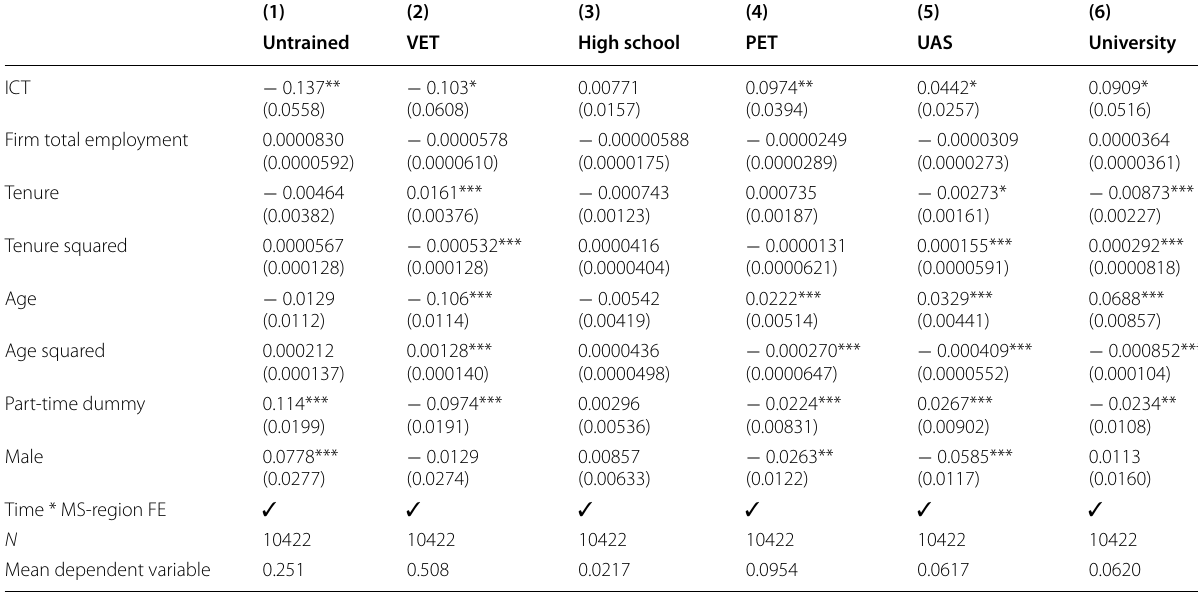
The table shows OLS coefficients of fixed effects estimates of a firm pseudo-panel with cells defined based on MS-region, industry, and firm size. Standard errors in parentheses are clustered at the cell level. N reports the number of pseudo-panel cells that contain at least one firm. The main explanatory variable measures the cell percentage of ICT workers according to ICT tasks (1996–2010) or ICT occupations (2012–2018). Estimates further control for time*MS-region fixed effects and cell averages of total employment, tenure, age, part-time status, and gender. Each column shows the results for a different dependent variable measuring the percentage